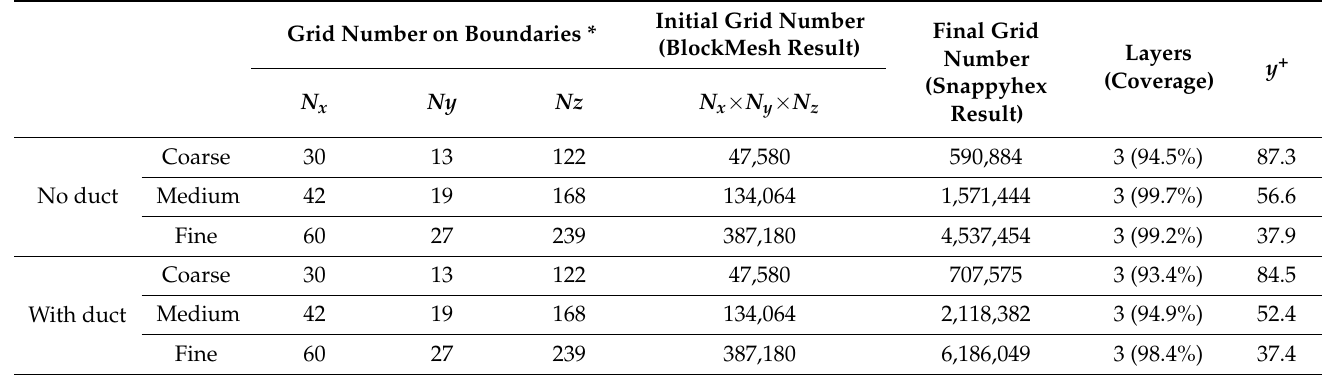
Table 1. Grid generation result.